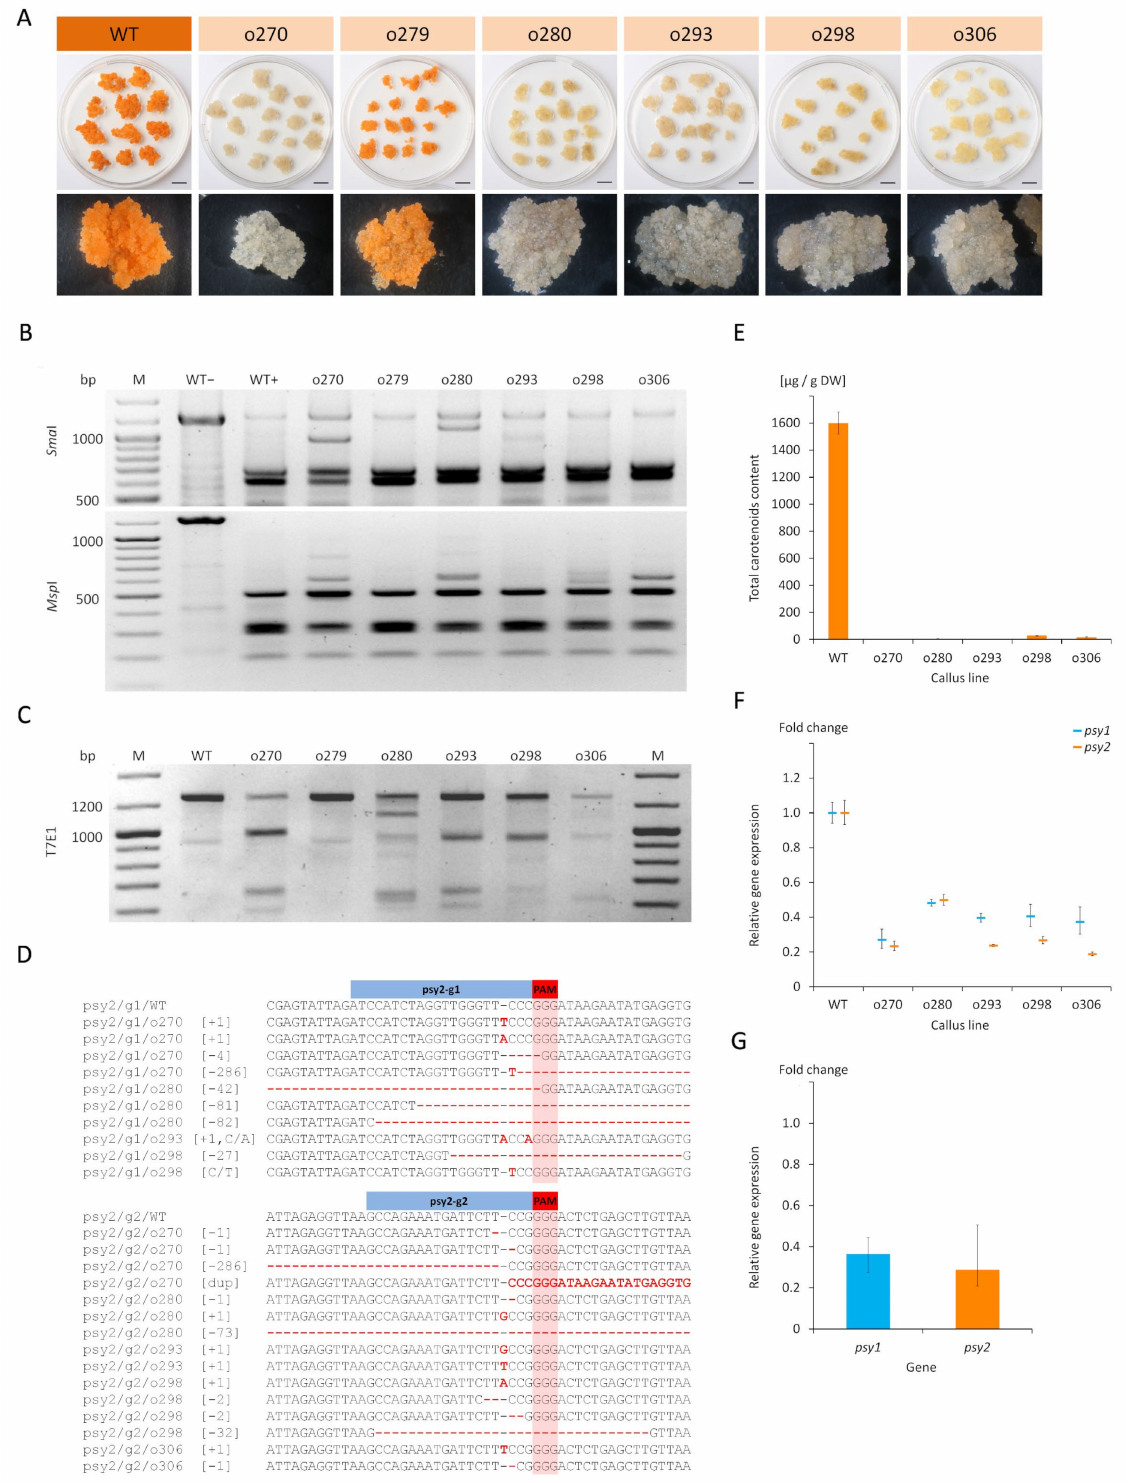
Figure 3. Carrot callus lines selected after transformation using the psy2-g1g2 vector with gRNAs targeting the psy2 gene. ( A ) Developing callus in vitro. Separation of PCR fragments after restriction with ( B ) specific endonucleases and ( C ) T7EI enzyme. ( D ) Results of Sanger sequencing of target sites in the psy2 gene. ( E ) Total carotenoid content. Relative psy1 and psy2 gene expressions in ( F ) each callus line and ( G ) the mean relative expressions. Scale bars represent 1 cm; WT − wild type callus (not transformed control) before (–) and after (+) restriction; o270-o306–transgenic callus lines; M—GeneRuler DNA Ladder Mix (Thermo Scientific)